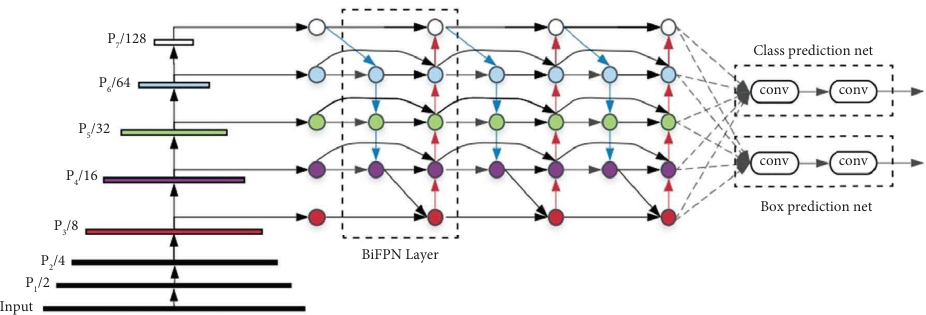
Figure 13: Te framework of EfcientNet.